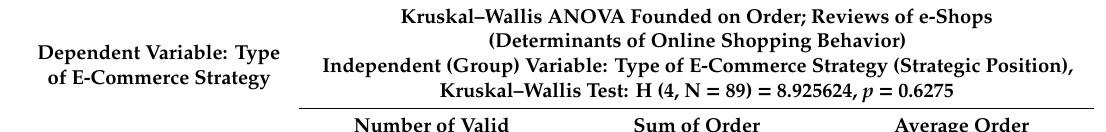
Table 5. Kruskal–Wallis ANOVA founded on order; Example: Reviews of e-shops according to type of e-commerce strategy. Source: own processing (in the Statistica software).